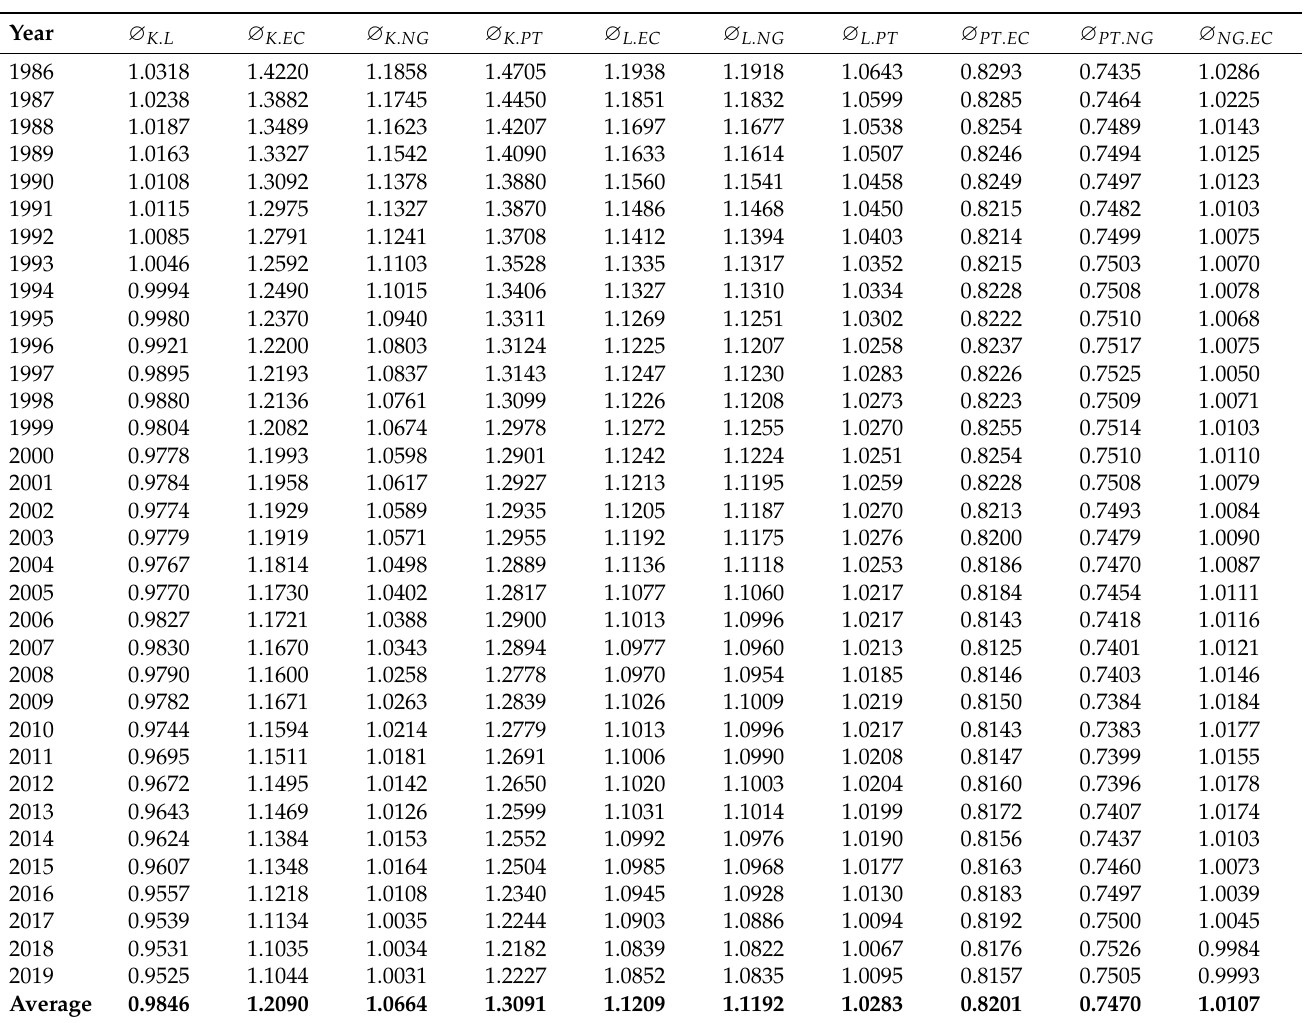
Table 4. Elasticity of substitution of alternative from